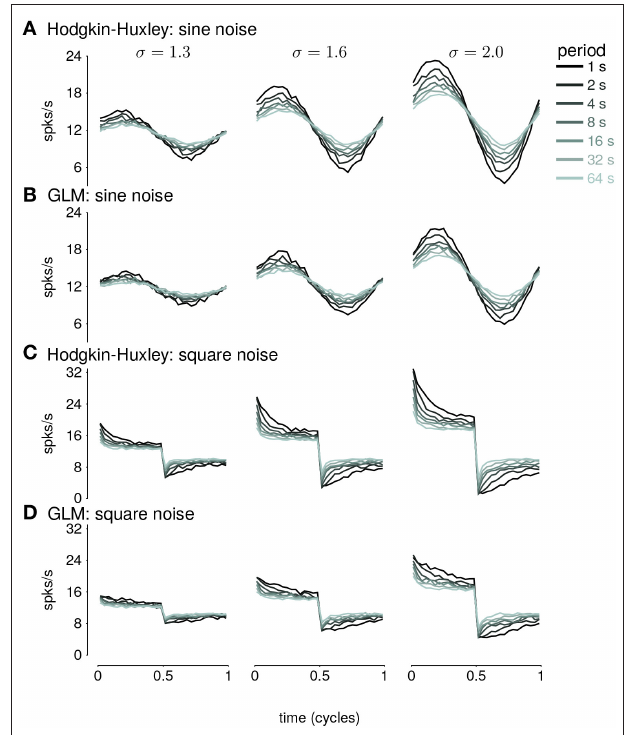
FIGURE 8 | (A) The cycle-averaged response of the simulated Hodgkin-Huxley neurons with three AHP currents to sine wave modulated noise. Each trace shows the average response for a different period of noise modulation. The columns show the responses to different strengths of stimulus noise modulation ( σ ). (B) The cycle-averaged response of a GLM fit to the HH simulations in (A) . The GLM used a 16 s spike history filter. (C) The cycle-averaged response of the HH neurons to square-wave modulated noise. (D) The cycle-averaged response of a GLM fit to the HH simulations in (C) . The cycle averages can be compared to the exact fractional derivatives in Figures 2B,D